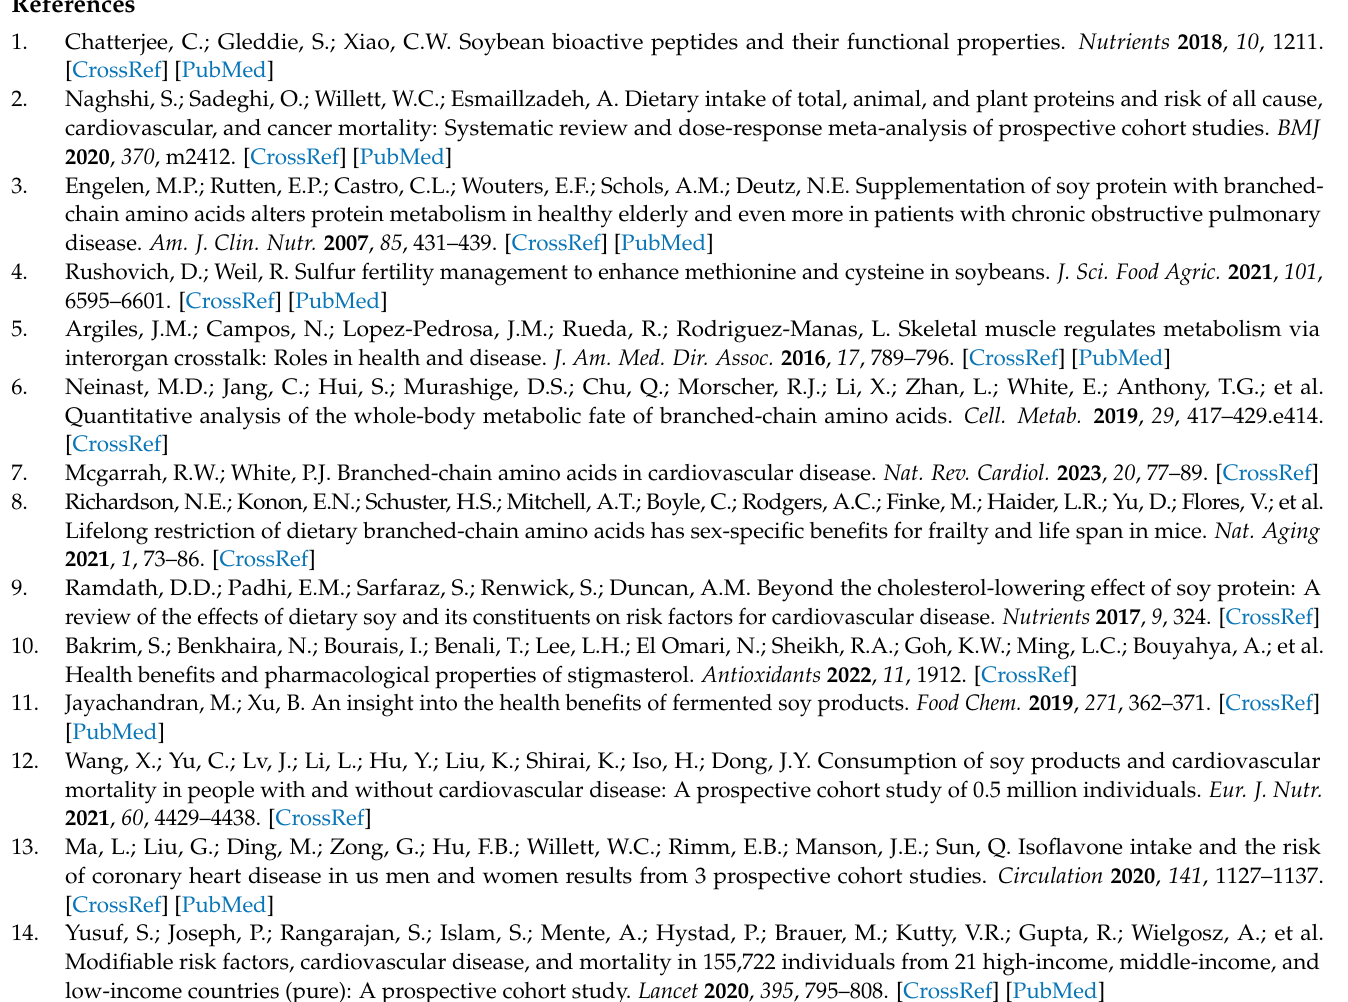
cardiovascular diseases, (C) type 2 diabetes with the consumption of soy foods, Figure S5: Sensitivity analysis of risk association of type 2 diabetes (A) and cardiovascular diseases (B). References